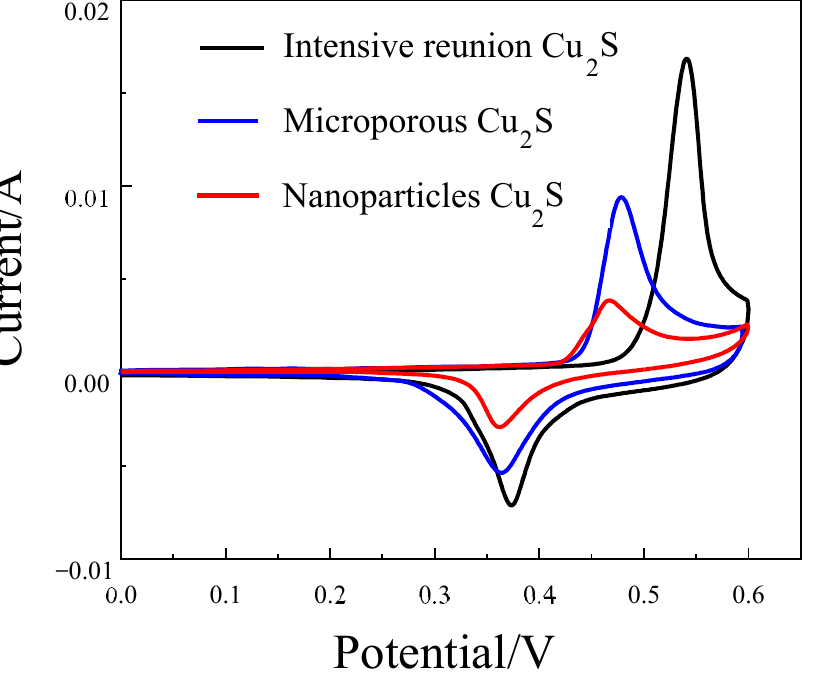
Figure 8. The cyclic voltammetry diagram curves of intensive reunion Cu 2 S, microporous Cu 2 S, and nanoparticles Cu 2 S.